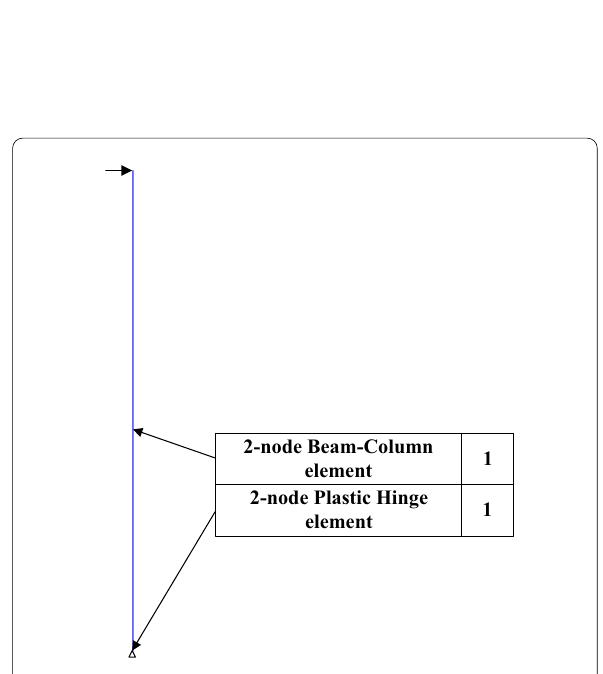
Fig. 10 Finite element model for NS and FS